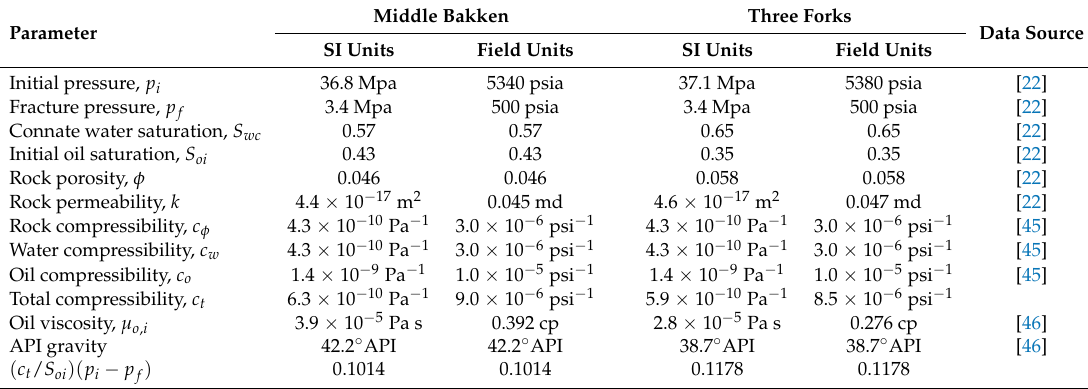
Table A1. Reservoir properties used in scaling oil production in the Middle Bakken and Three Forks